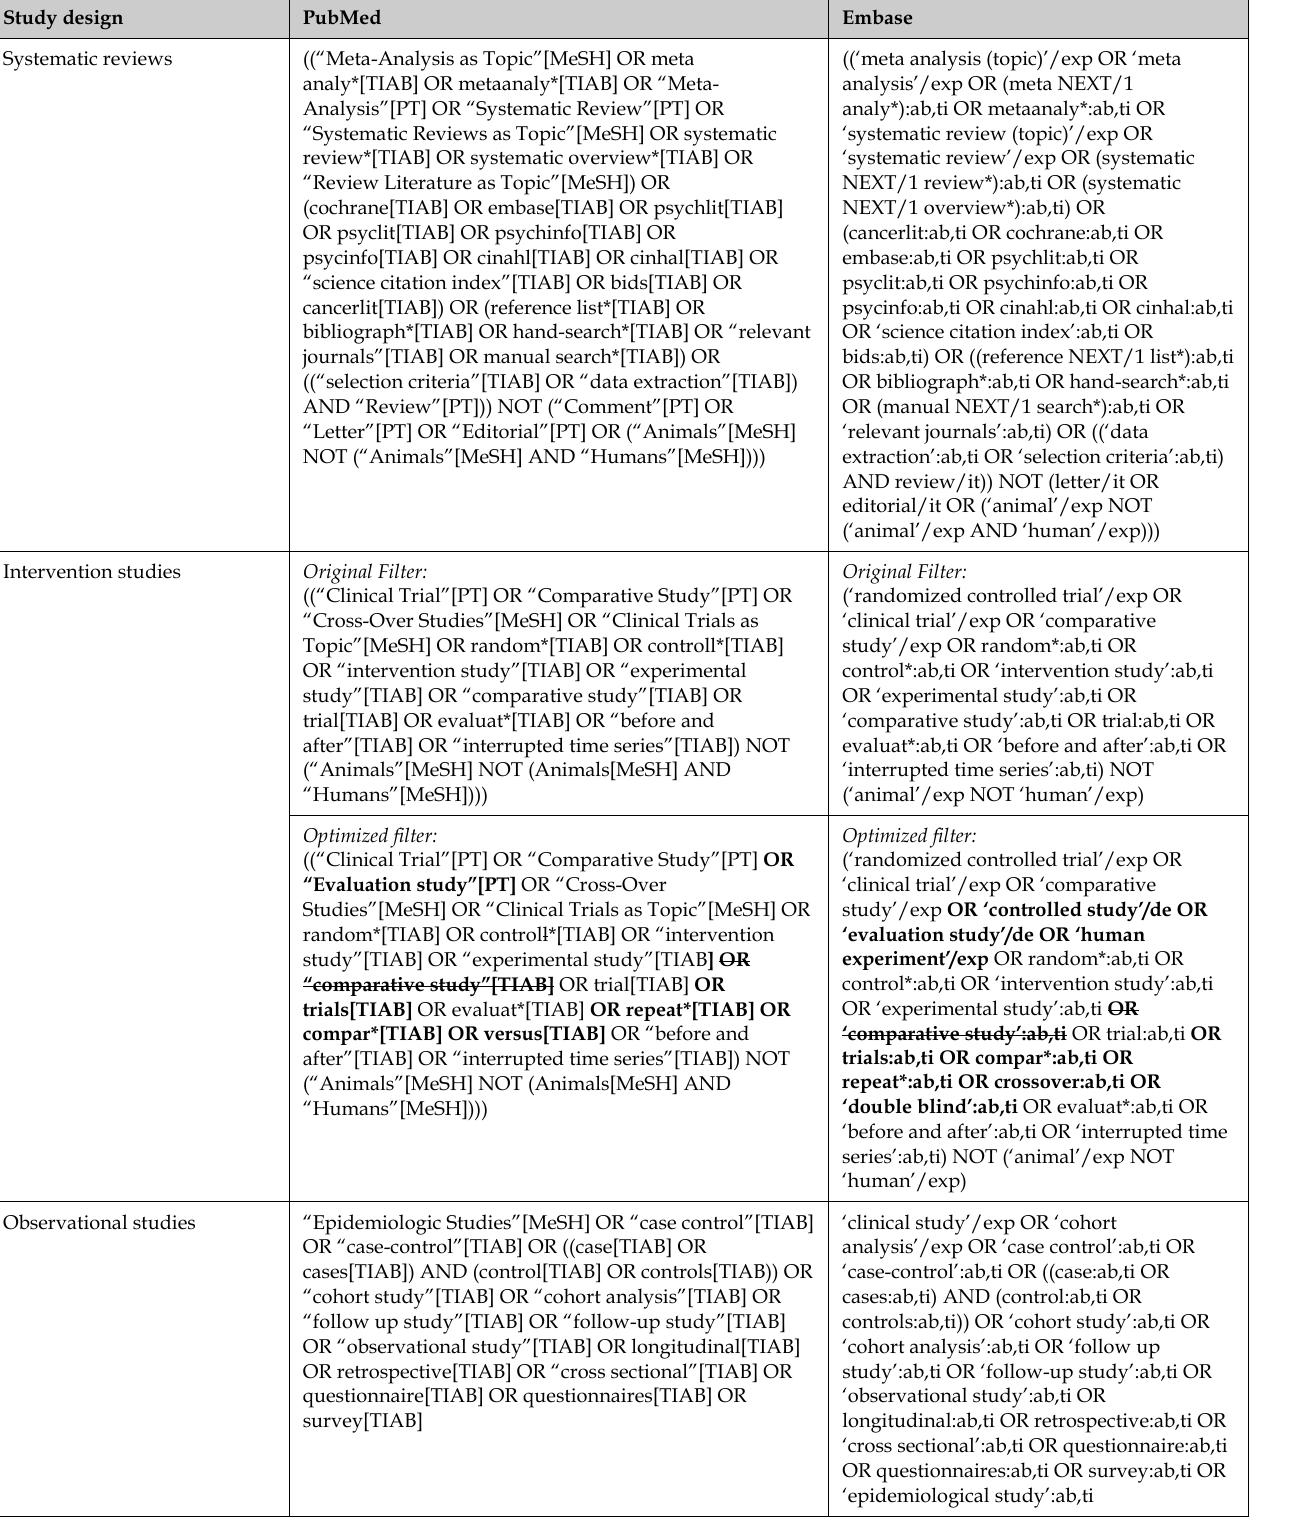
Table 1 Methodological search filters